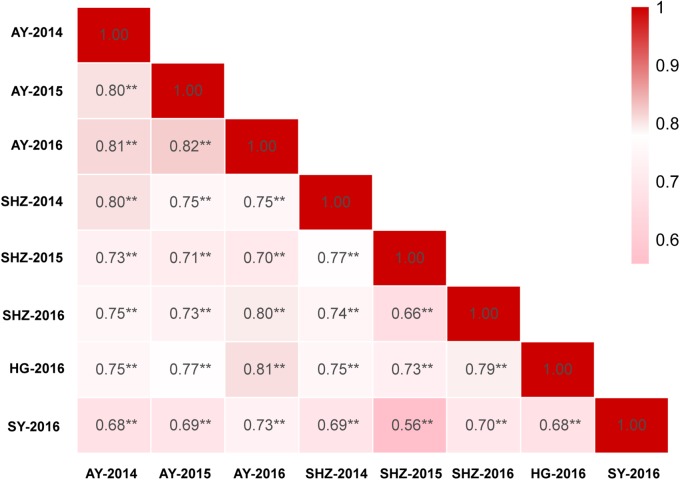
Correlation analyses of fiber length (FL) based on eight environments among 355 accessions. ∗∗Indicates that the correlation reached significance at 0.001.